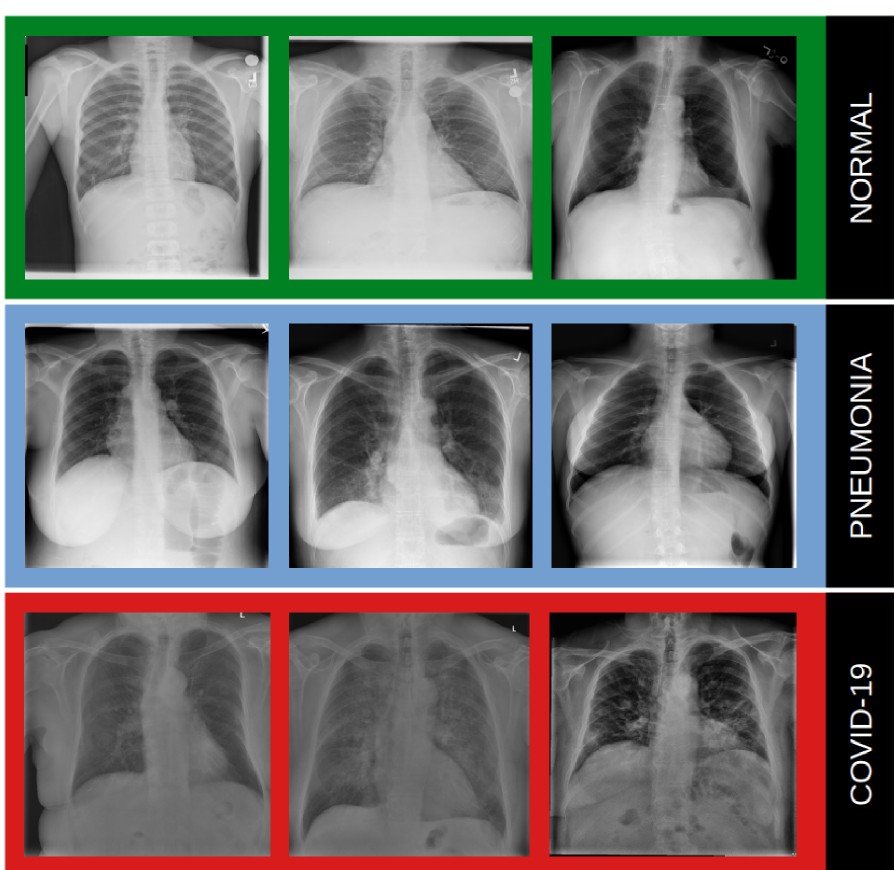
Fig 1. Examples of samples from the dataset: Normal (healthy), pneumonia and COVID-19.